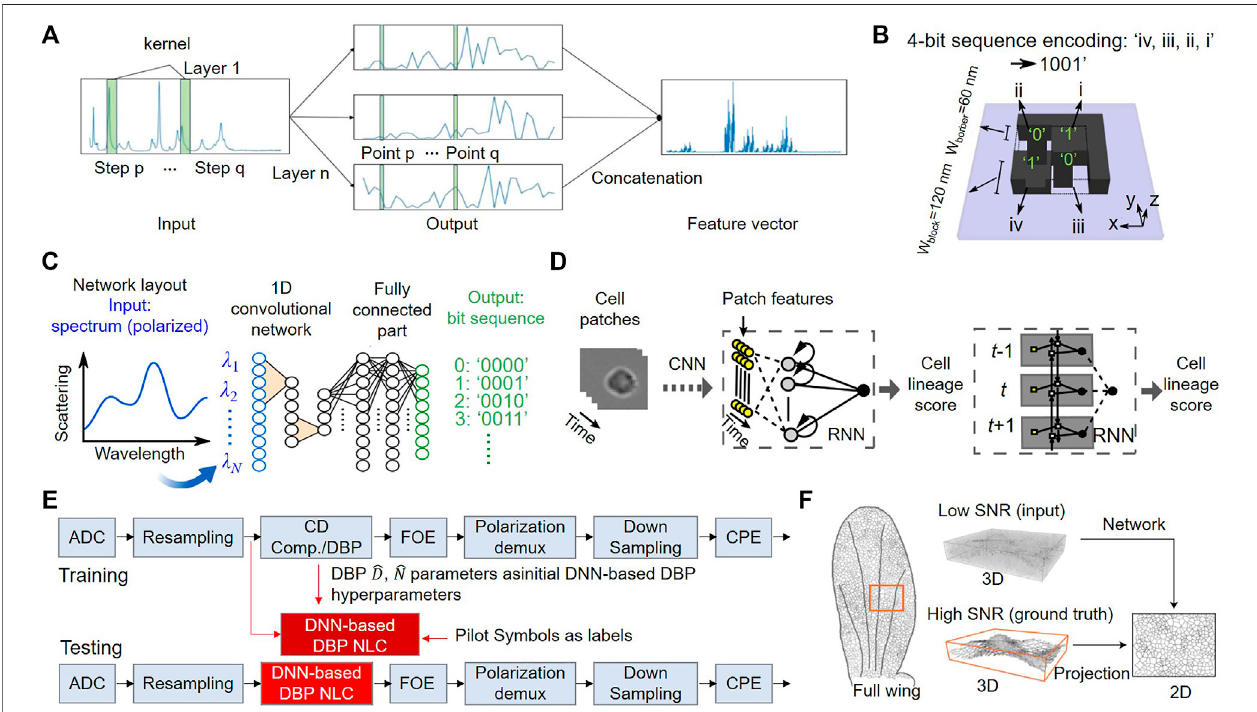
FIGURE4| Deeplearningforopticaldataanalysis. (A) WorkingprincipleofCNNused inspectralanalysis.Reproduced fromFanetal.(2019)withpermissionfrom the Royal Society of Chemistry. (B) Schematic of 4-bit nanostructure geometry. (C) Illustration of CNN applied for information storage. Reproduced from Wiecha et al. (2019) with permission from Springer Nature. (D) Schematic of CNN used for classi fi cation of differentiated cells. Reproduced from Buggenthin et al. (2017) with permission from Springer Nature. (E) DNN-based DBP architecture. FOE: frequency-offset estimation, CPE: carrier-phase estimation. Reproduced from Fan et al. (2020) with permission from Springer Nature. (F) The proposed CARE for image restoration. Reproduced from Weigert et al. (2018) with permission from Springer Nature.